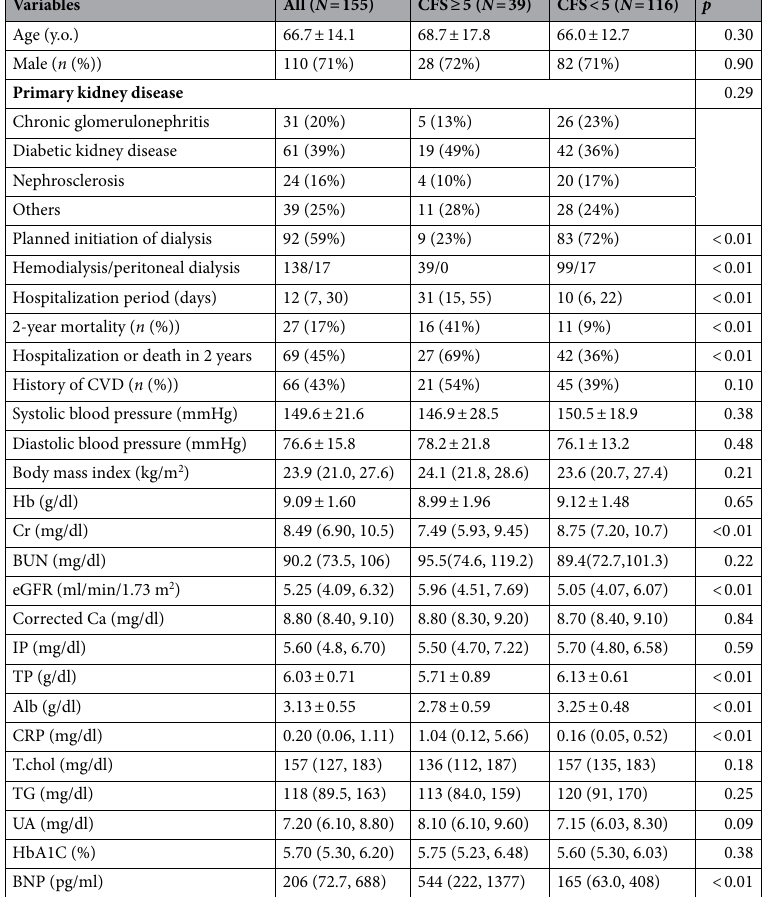
Table 1. Comparison between groups with mean CFS scores of more or less than 5. Continuous data are presented as mean ± SD or median (IQR): CVD cardiovascular disease, Hb hemoglobin, Cr creatinine, BUN blood urea nitrogen, Egfr estimated glomerular filtration rate, Ca calcium, IP phosphate, TP total protein, Alb albumin, CRP C-reactive protein, T.chol total cholesterol, TG triglyceride, UA uric acid, HbA1C hemoglobinA1C, BNP brain natriuretic